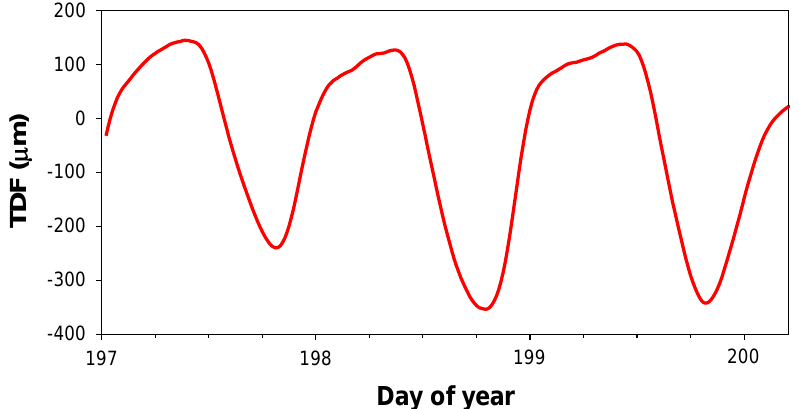
Figure 13. Evolution of trunk diameter fluctuations (TDF) of the RDI30 treatment trees during deficit irrigation period (stage IV). The data was stored by node 23 equipped with linear variable displacement transducer sensors (year 2019).